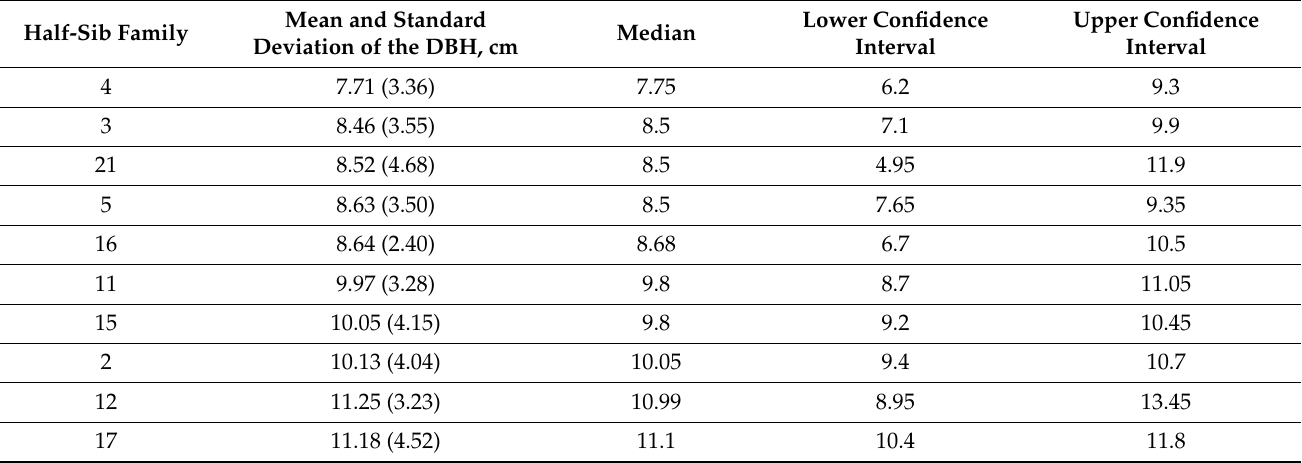
Table 1. Parameters of the DBH of the examined